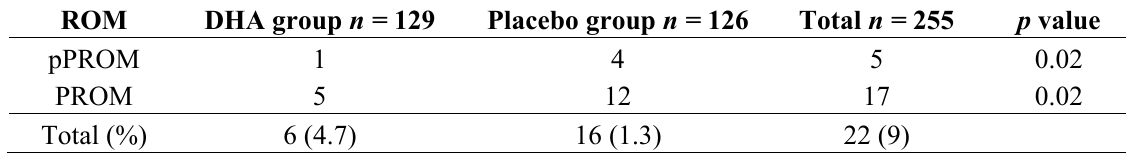
Table 3. Cases of ROM observed during the pivotal